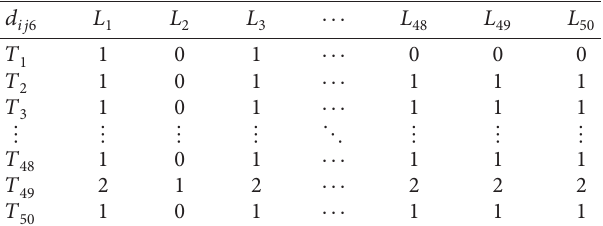
� [ d ] for tenants’ ij 7 7 50 × 50